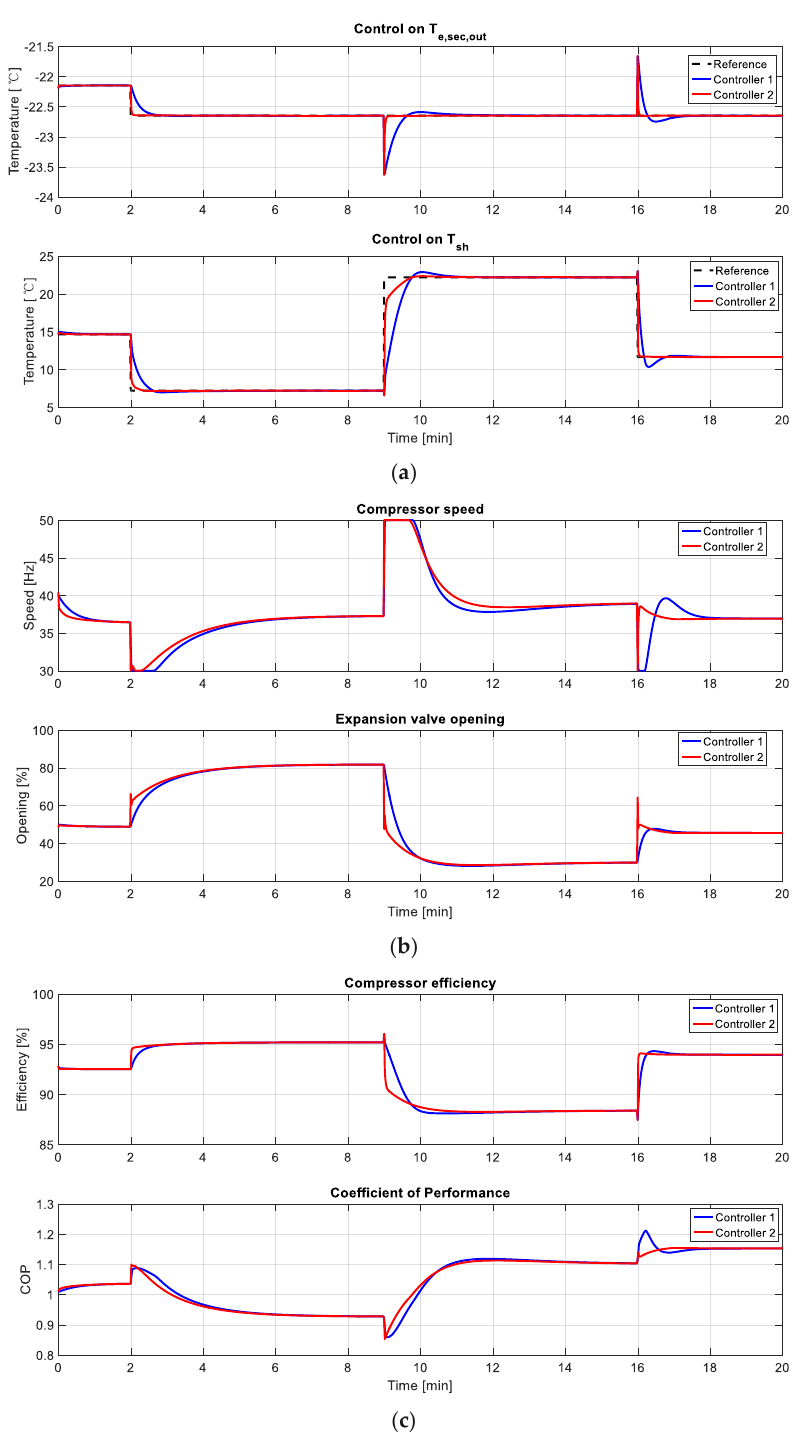
Figure 11. Simulation result of step response: ( a ) step response curves of T e,sec,out and T sh ; ( b ) trend curves of A v and N ; ( c ) trend curves of the compressor efficiency and COP.